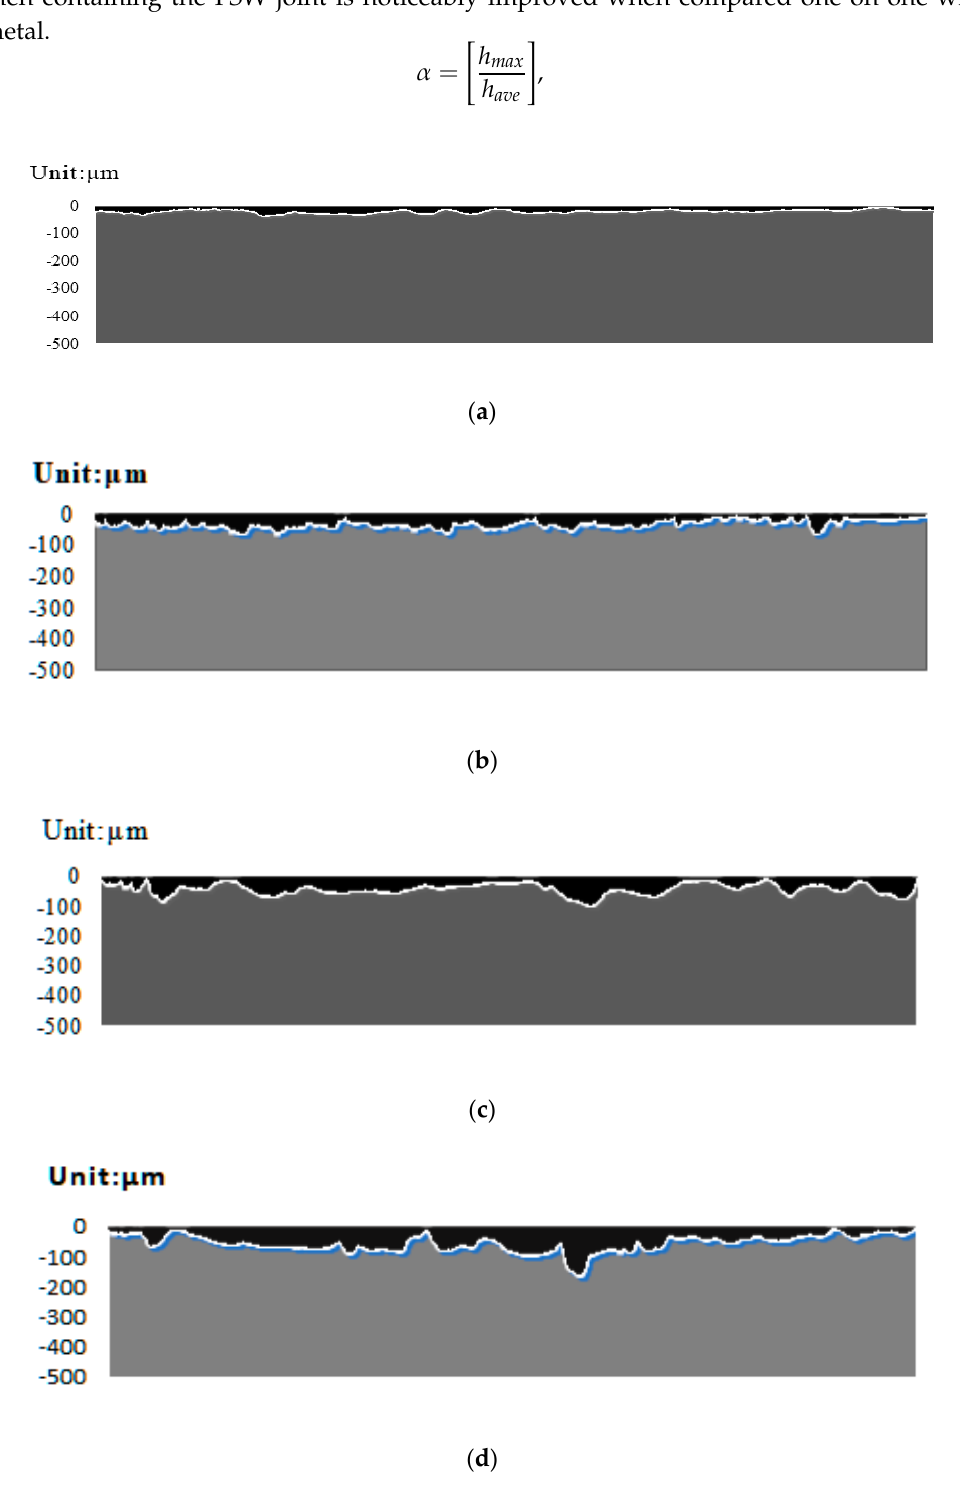
Figure 11. Corrosion damage of the longitudinal section of test specimen containing an FSW joint: ( a ) stress corrosion damage profile model of FSW joint specimen (duration of exposure = 8 h, σ = 118.5 MPa); ( b ) stress corrosion damage profile model of FSW joint specimen (duration of exposure = 16 h, σ = 118.5 MPa); ( c ) stress corrosion damage profile model of FSW joint specimen (duration of exposure = 24 h, σ = 118.5 MPa); ( d ) stress corrosion damage profile model of FSW joint specimen (duration of exposure = 48 h, σ = 118.5 MPa).